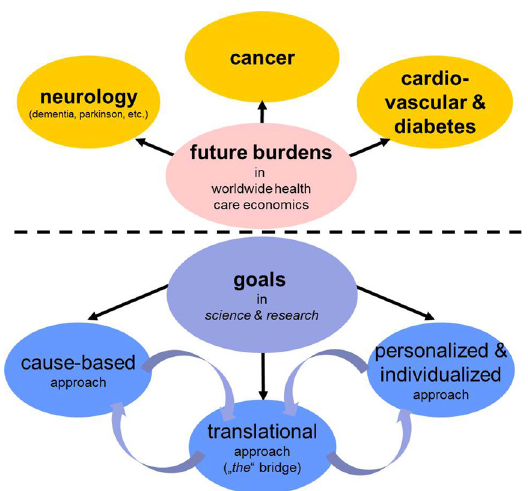
Figure 2. Future burdens in worldwide healthcare economics de fi negoalsinscience&research:theneedofcause-basedresearch to replace a symptom-orientated approach with translational research as the bridge as the focus shifts to personalized and individualized approach (diagnosis and